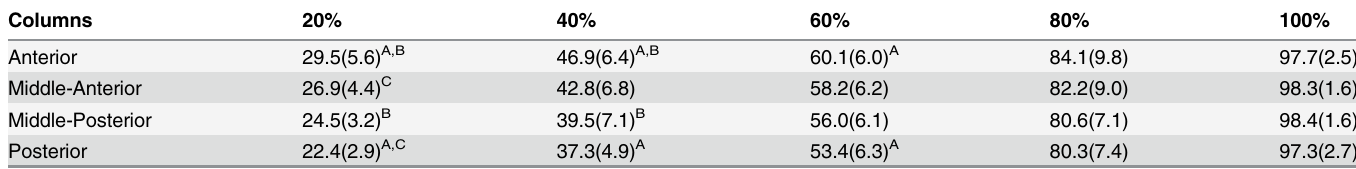
%: percent of maximal voluntary bite force. A Statistically signi fi cant difference between the Anterior and Posterior columns (p-value < 0.05). B Statistically signi fi cant difference between the Anterior and Middle-posterior columns (p-value = 0.001).